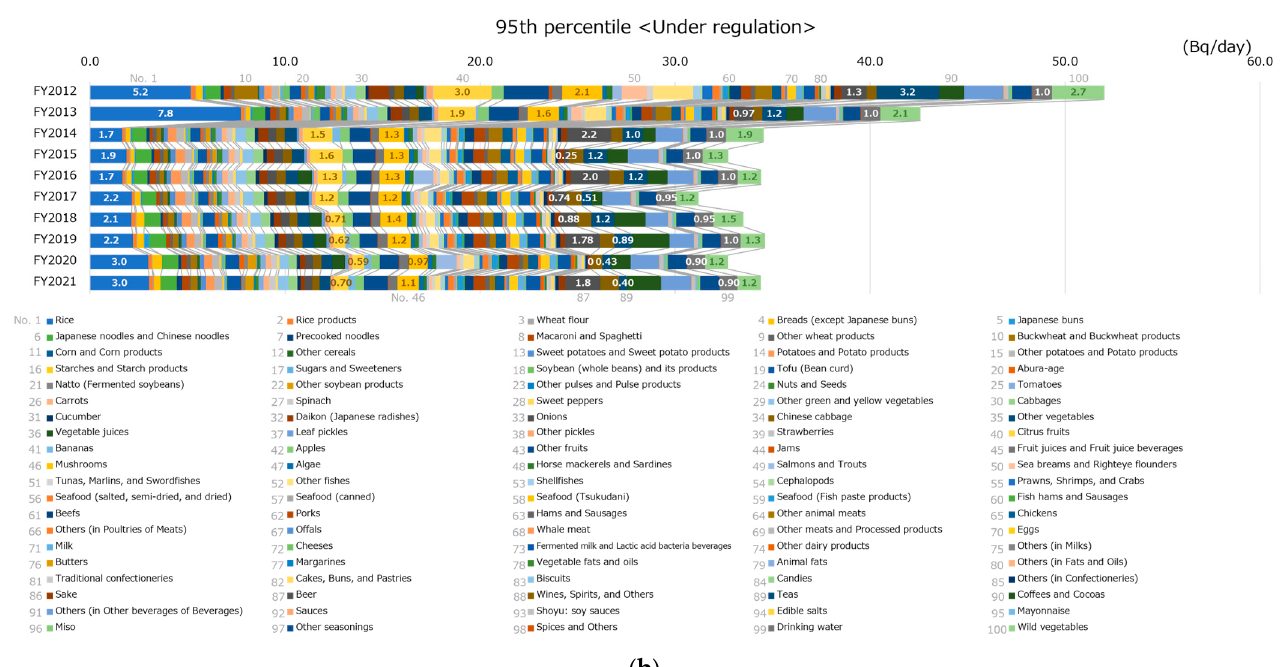
Figure 4. Breakdown of cesium ingestion per food classification: ( a ) median and ( b ) 95th percentile of cesium ingestion by 10,000 virtual persons. The percentile values of cesium ingestion in each food category were obtained, and the values for all food categories were summarized for each percentile. Hence, it does not necessarily mean that the same virtual person ingests them all. For food classifications with moderately high cesium ingestion, the values of cesium ingestion are also indicated in the figure. Specifically, values for rice, citrus fruits, mushrooms, beer, teas, drinking water, and wild vegetables are included.